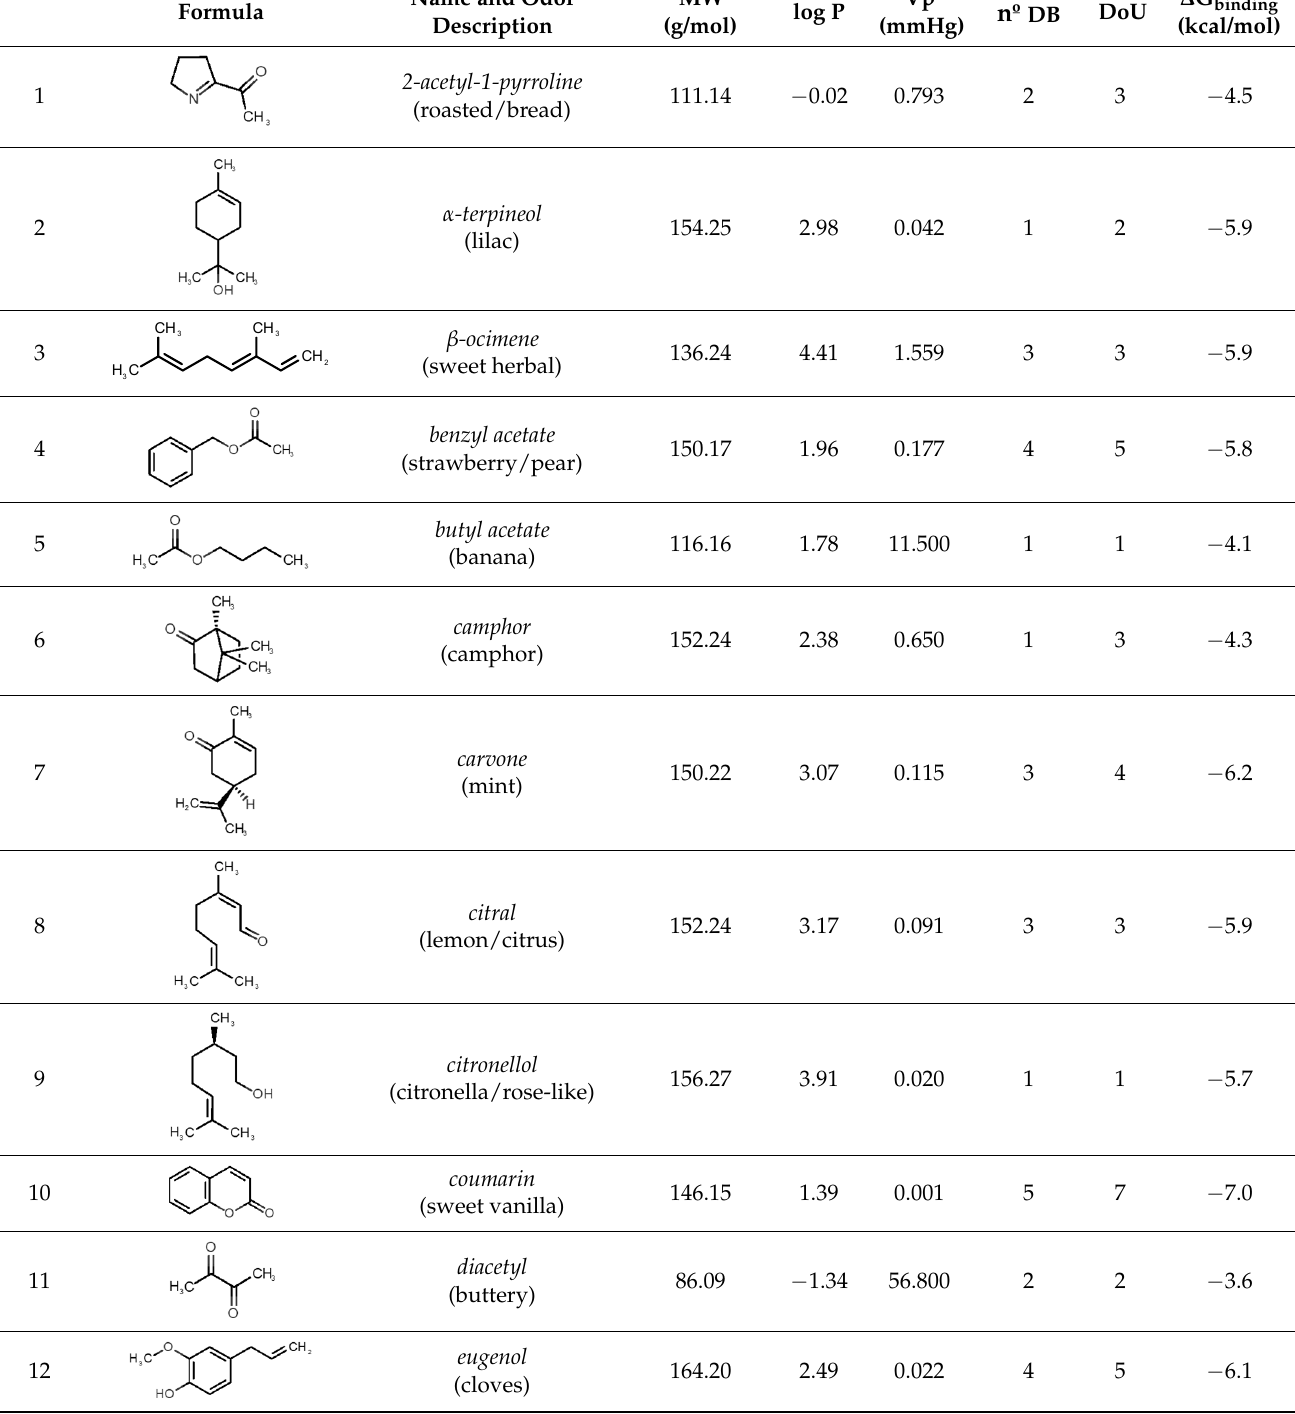
Table 1. Description of pleasant odorant molecules under study, according to the physicochemical and structural characteristics.